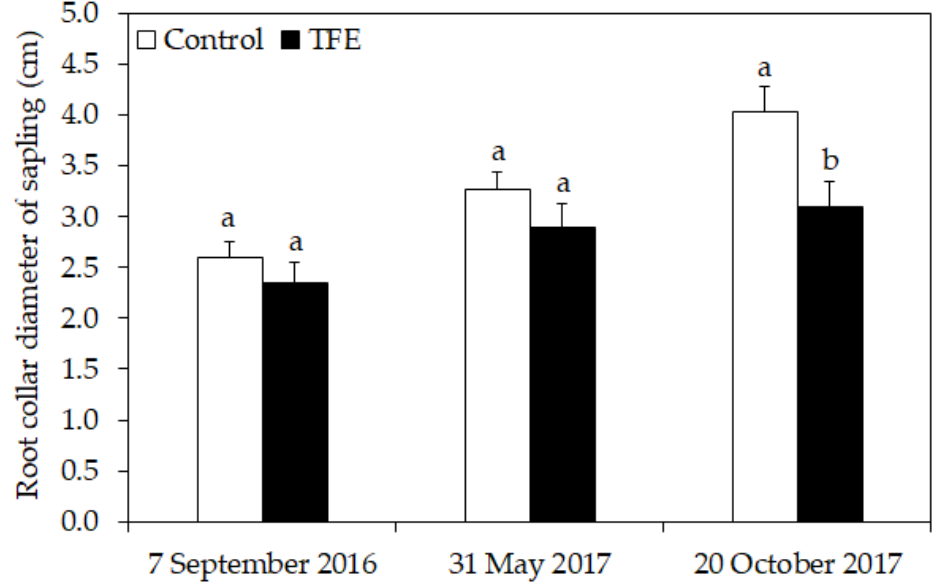
Figure 9. Root collar diameter increment of Korean pine saplings in the control and TFE plots with standard error (error bars). Different Latin letters indicate significantly different between control and TFE plots within each measuring day ( p < 0.05). ( n = 15 for control plots, n = 19 for TFE plots).